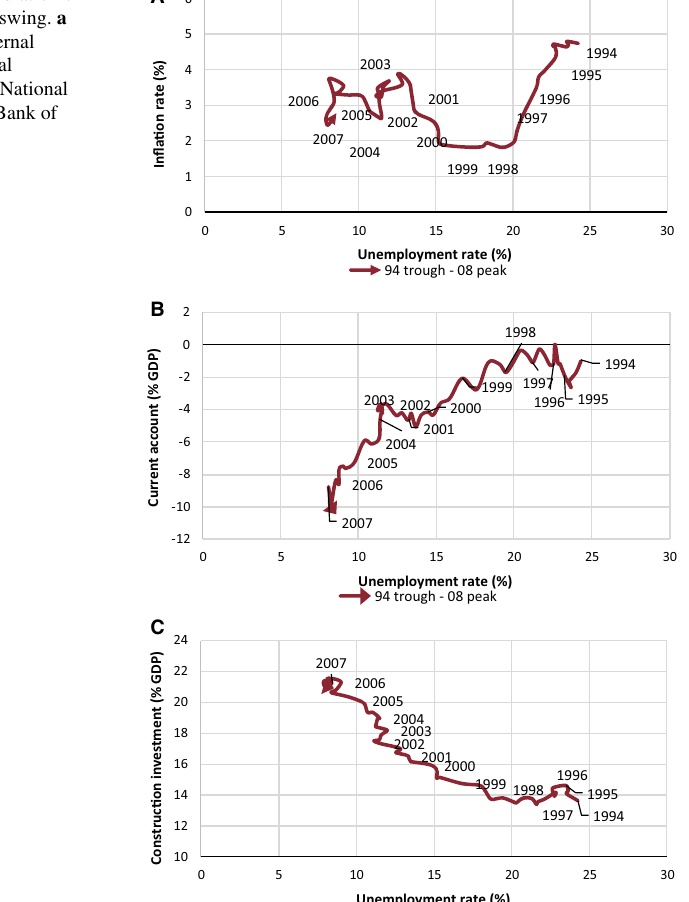
Fig. 2 Spanish accumulation of imbalances in the upswing.